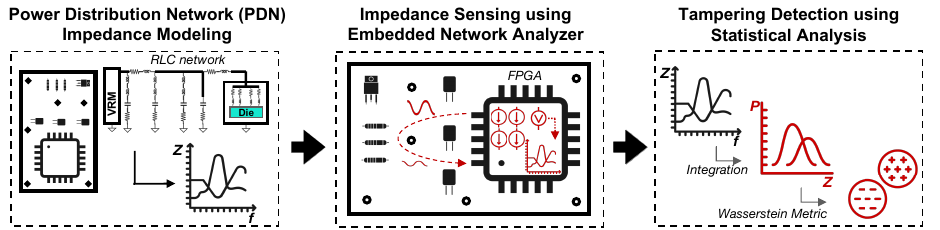
Figure 1: The concept of the ImpedanceVerif framework: (i) Modeling the PDN impedance as an RLC circuit, (ii) Characterizing the impedance of this RLC network using an embedded network analyzer on FPGAs, and (iii) performing statistical analysis for detecting tamper events using Wasserstein